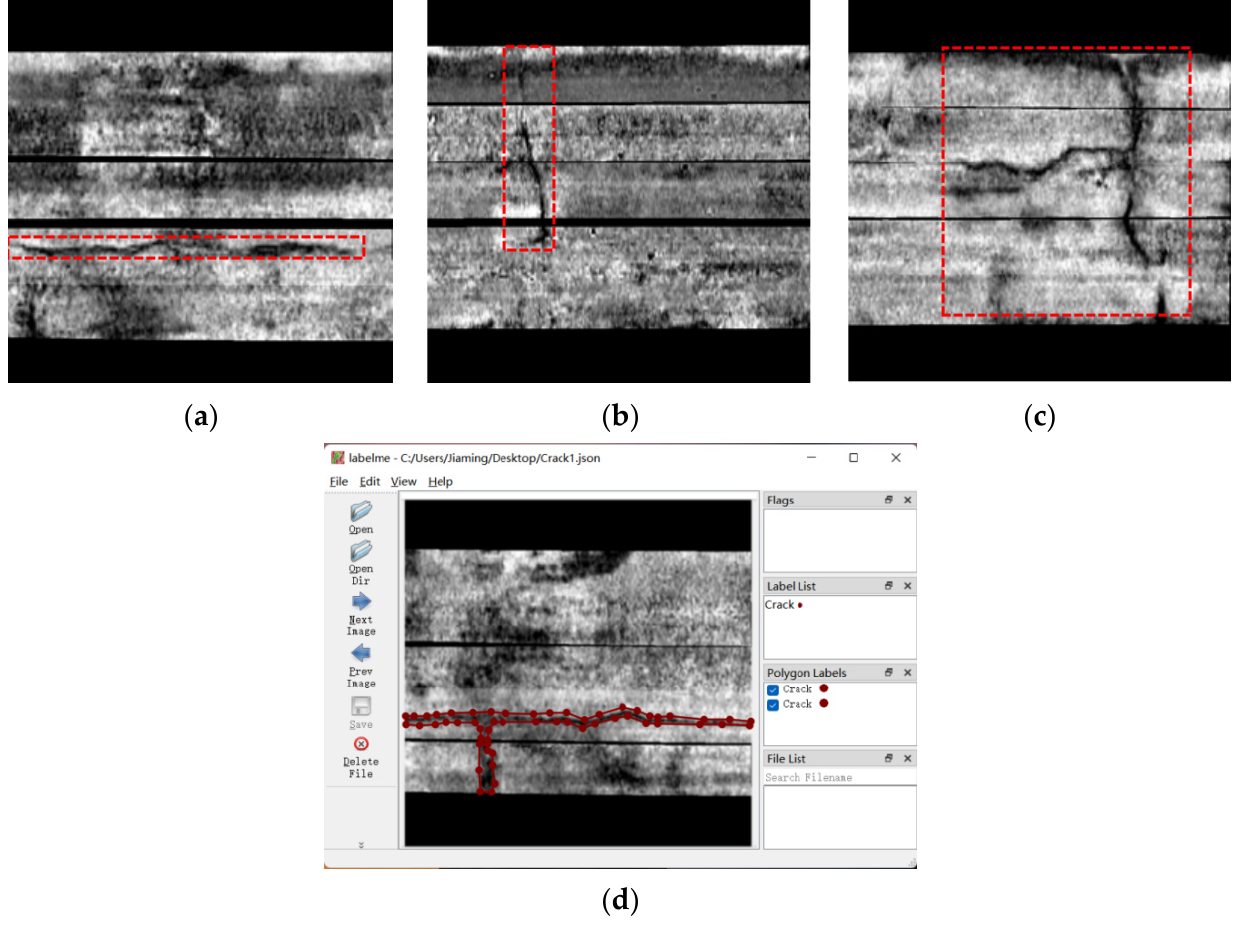
Figure 7. Three types of crack fractures (labeled by the red boxes) and the labeling process. ( a ) Lon- gitudinal crack. ( b ) Transverse crack. ( c ) Cross crack. ( d ) Labelme labeling process.